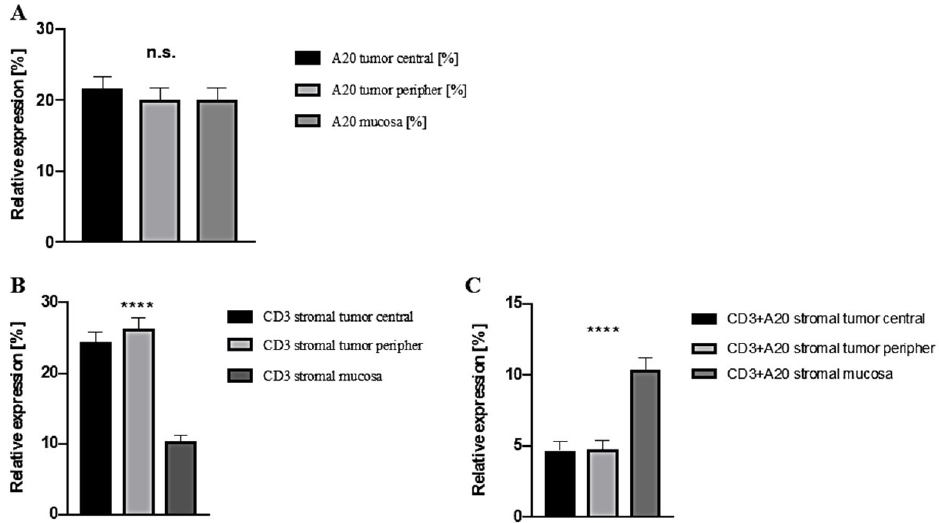
Figure 2. ( A ) Analysis of relative A20 IHC expression in central and peripheral OSCC as well as non-malignant mucosa ( n = 172); ( B ) Expression of stromal CD3+ T cells in the tumor center, the tumor periphery and non-malignant mucosa; ( C ) A20 IHC expression within stromal CD3+ T cells in tumor center, tumor periphery as well as non-malignant mucosa; **** p < 0.0001, n.s. = not significant.